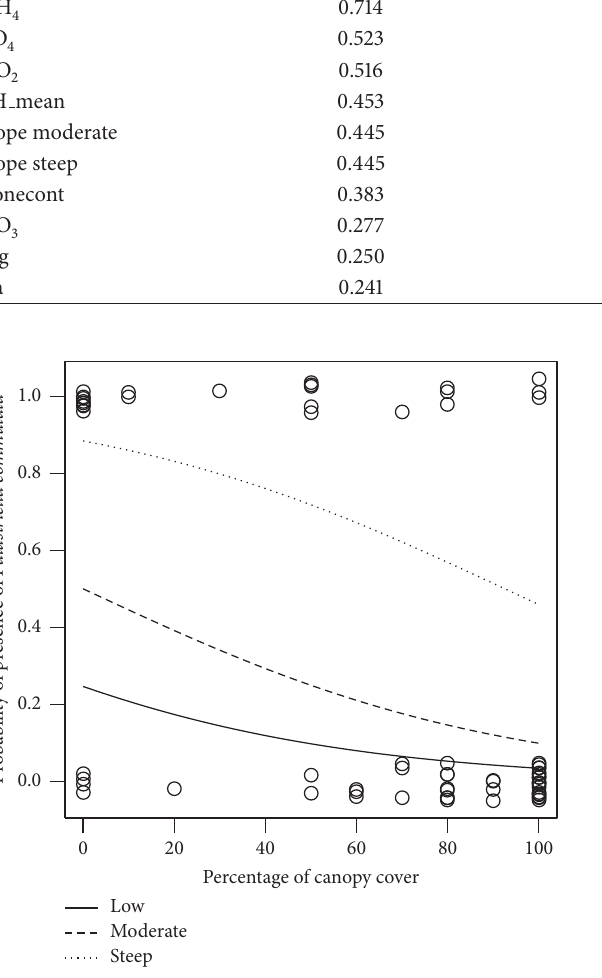
Figure 5: Prediction of presence of Palustriella commutata in relation to canopy cover based on the coefficients of the best models selected by AIC stepwise selection for different slopes: low slope (solid line), moderate slope (dashed line), and steep slope (dotted line).